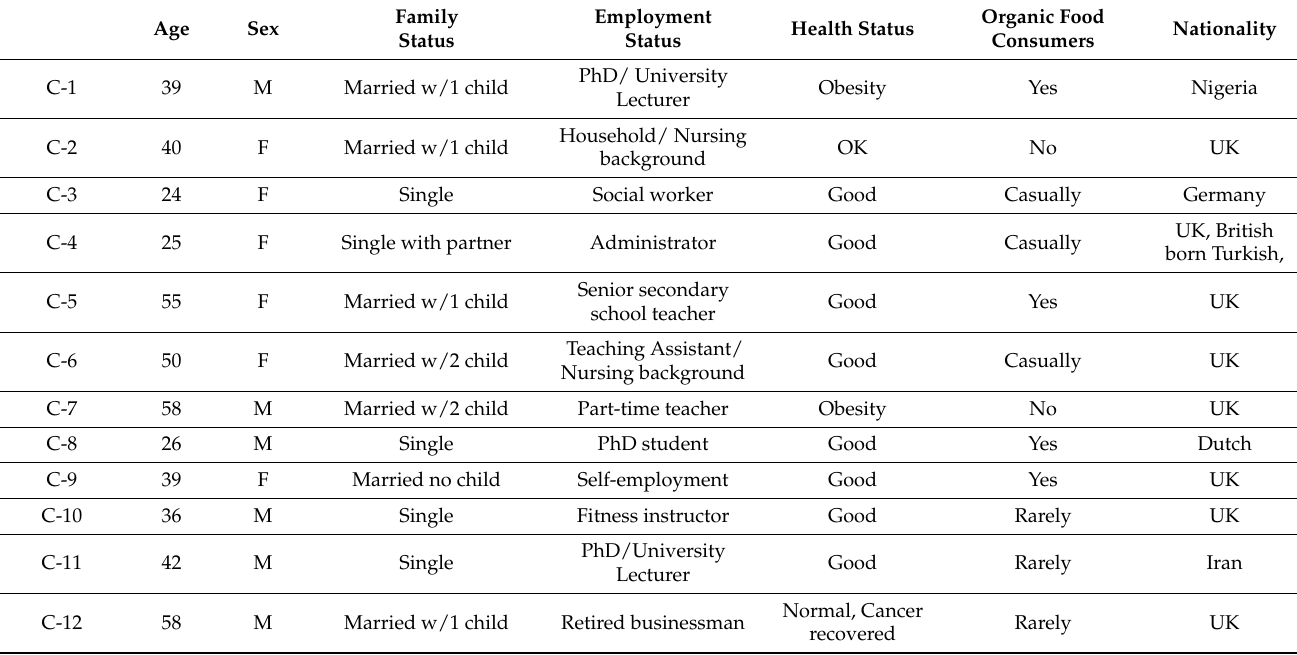
Table 2. Consumers’ background